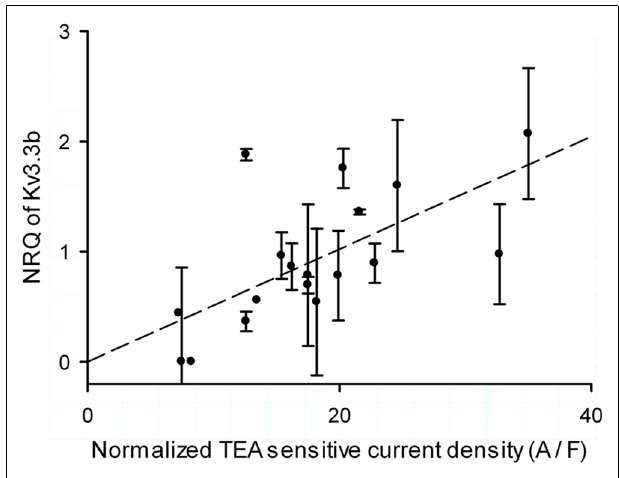
FIGURE 5 | Single cell correlation between current density and expression of Kv3.3b. Normalized inactivatingTEA sensitive Kv3.3 current density (normalized by capacitance of the clamped area of the cell) versus normalized relative quantity (NRQ) of Kv3.3b of each cell.The error bars were determined through calculating the error propagation of the normalized relative quantity of the Kv3.3b real time PCR